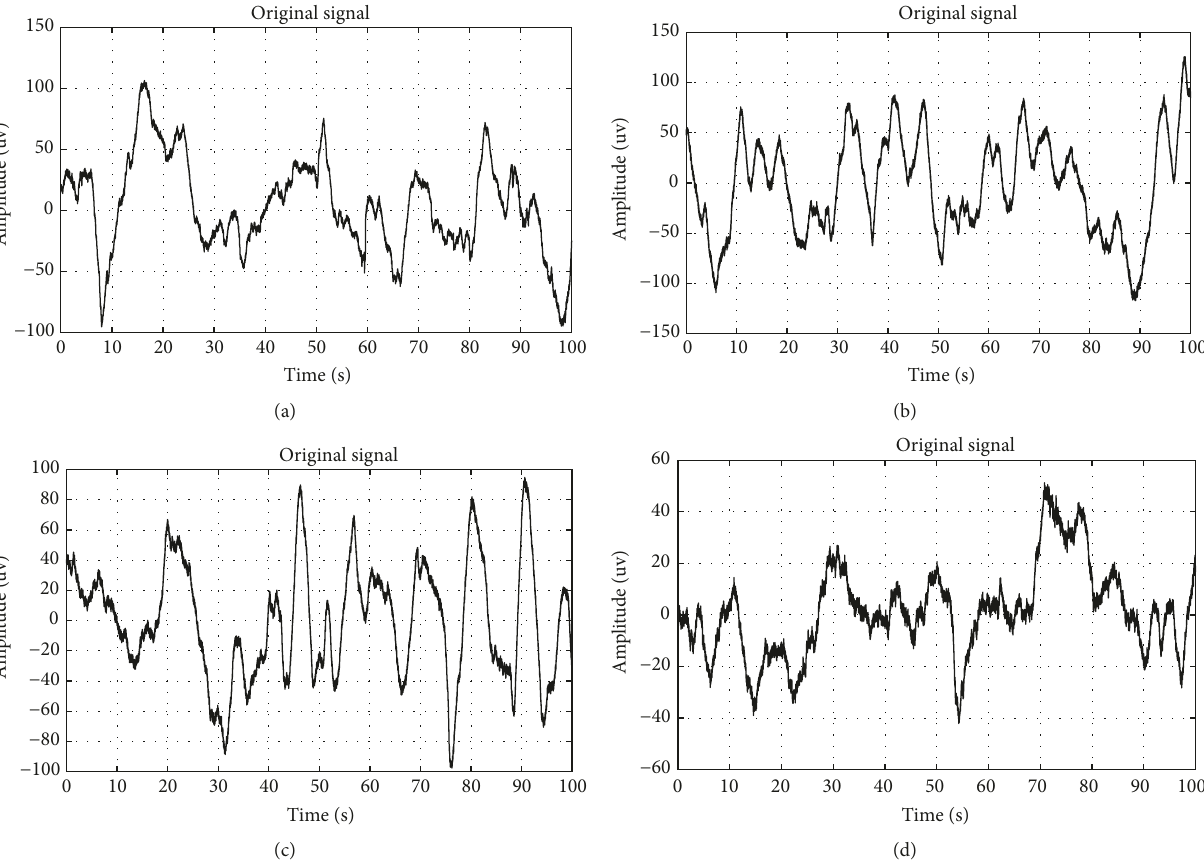
Figure 2: Time domain waveform of electrical signal of maize leaf under osmotic stress: (a) the normal growing condition; (b) the mild drought stress; (c) the moderate drought stress; (d) the severe drought stress.